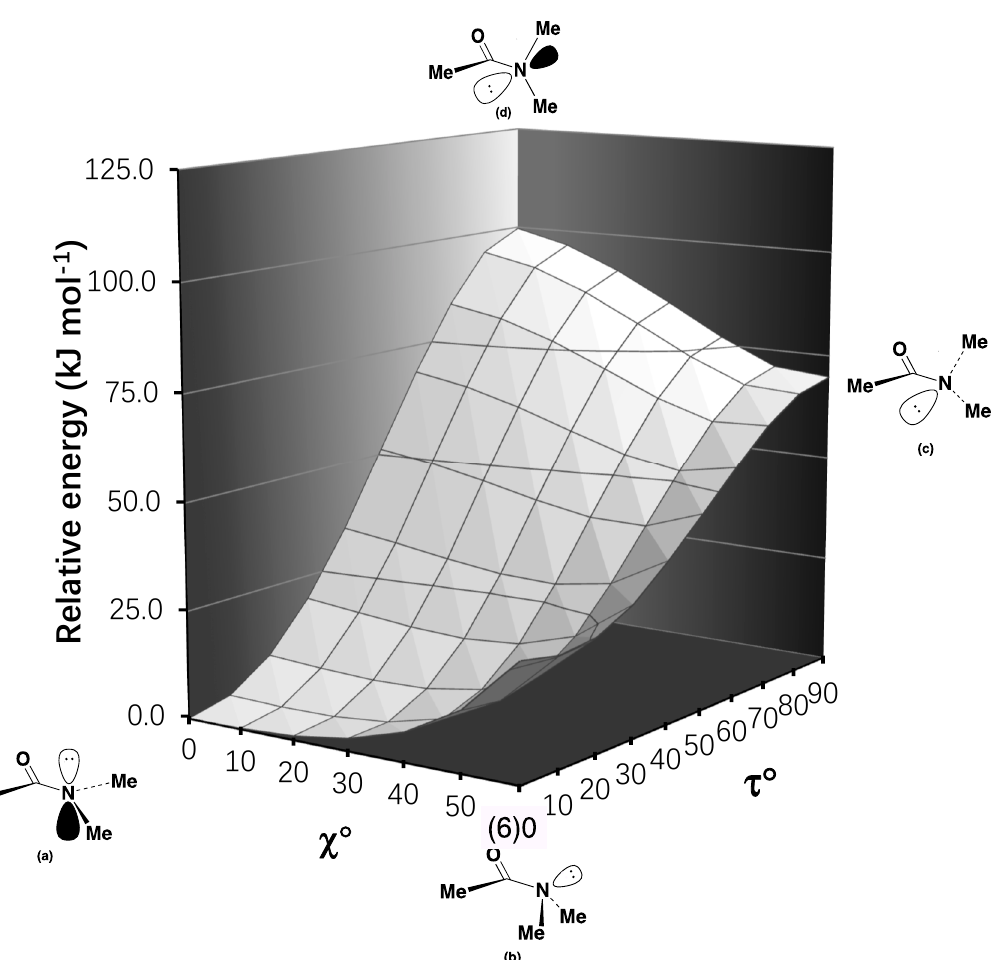
Figure 3. A B3LYP/6-31G(d) generated energy surface for the deformation of the amide moiety in N , N -dimethylacetamide 1 [4]. χ and τ are Winkler–Dunitz parameters for pyramidalisation and twist, respectively [5,6]. ( a ) The ground state planar structure for N , N -dimethylacetamide; ( b ) untwisted system with sp 3 hybridised nitrogen; ( c ) 90° rotation about N–C(O), whilst maintaining sp 3 hybridisation at nitrogen; and ( d ) the fully twisted moiety, 90° N–C(O) rotation and sp 2 hybridised nitrogen.